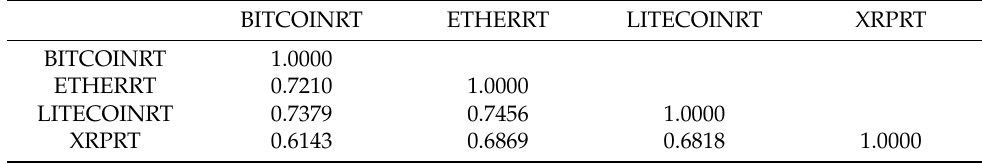
Table 13. DCC (1,1) Model.